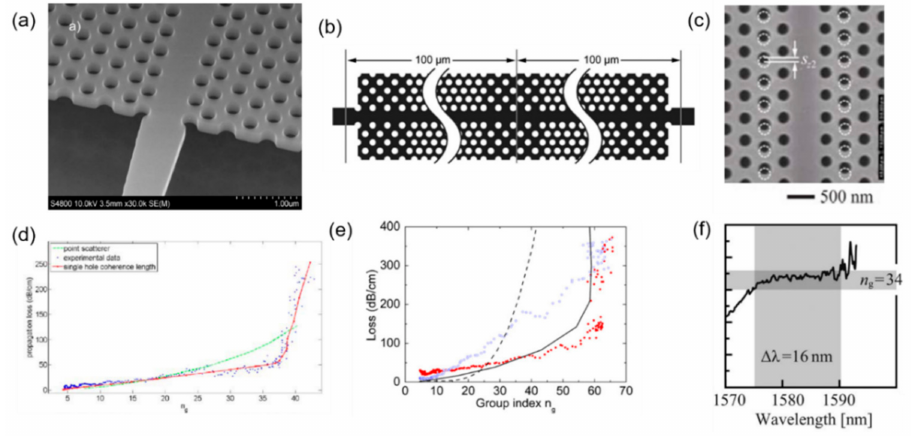
Figure 2. The structure and properties of photonic crystal waveguides. ( a ) SEM of a photonic crystal waveguide [35]. ( b ) The scheme of the slow–fast–slow mode conversion interface in the photonic crystal waveguide [36]. ( c ) SEM of fabricated photonic crystal waveguide with longitudinal lattice shifts in second rows [37]. ( d ) Loss as a function of group index in the manufactured photonic crystal waveguide [35]. ( e ) Loss of the photonic crystal waveguide as a function of group index with (red) and without (blue) slow–fast–slow mode conversion interface [36]. ( f ) Group index spectra for the photonic crystal waveguide with second-row longitudinal shifts